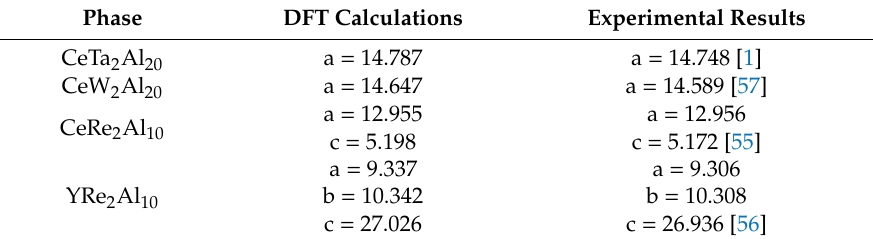
Table 4. Lattice parameters for the stable phases, in